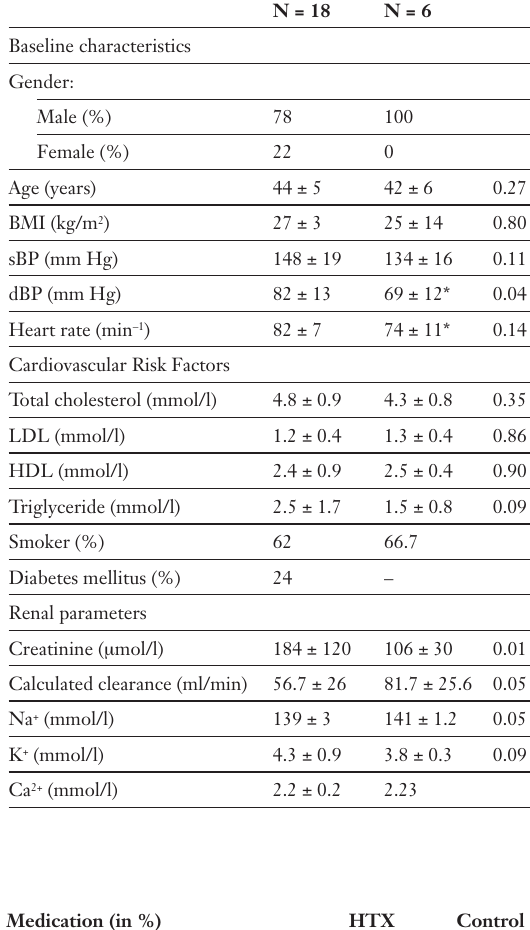
Medication taken by the patients recruited into the study. HTx: Heart-trans- planted patients; ACE: angiotensin converting enzyme, AT: angiotensin, Ca 2+ : calcium.